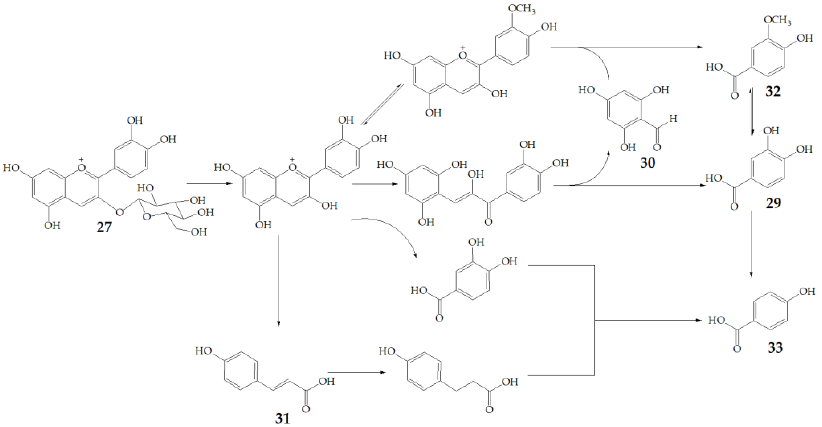
Figure 7. Biotransformation pathway of 27 .